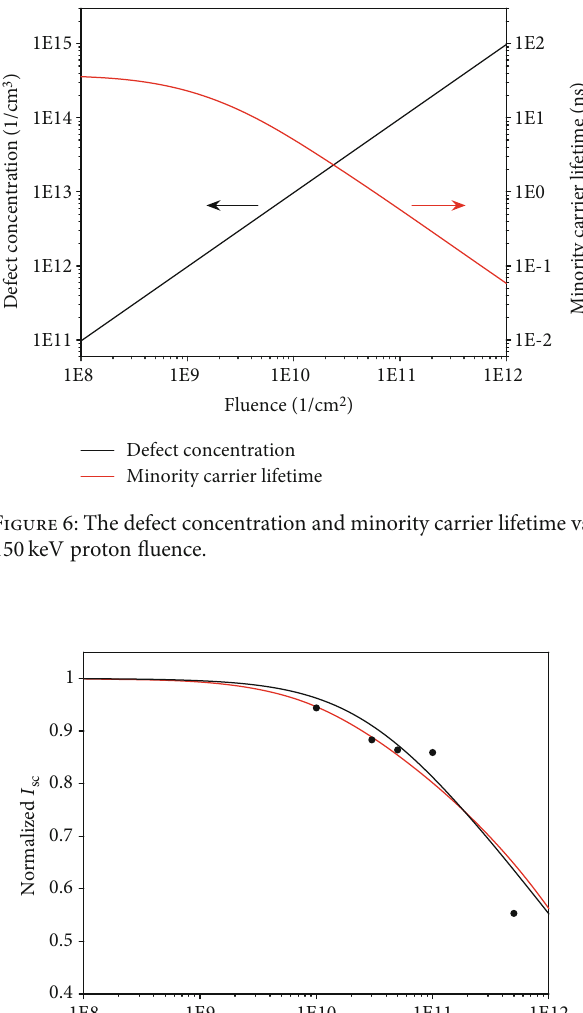
Figure 7, where the fi tting parameter A is 0.2879 and φ 2 : 8663 × 10 10 cm -2 . Mean square error of fi tting results and numerical calculation results compared with the experimen- tal data, respectively, are 25% and 19%.